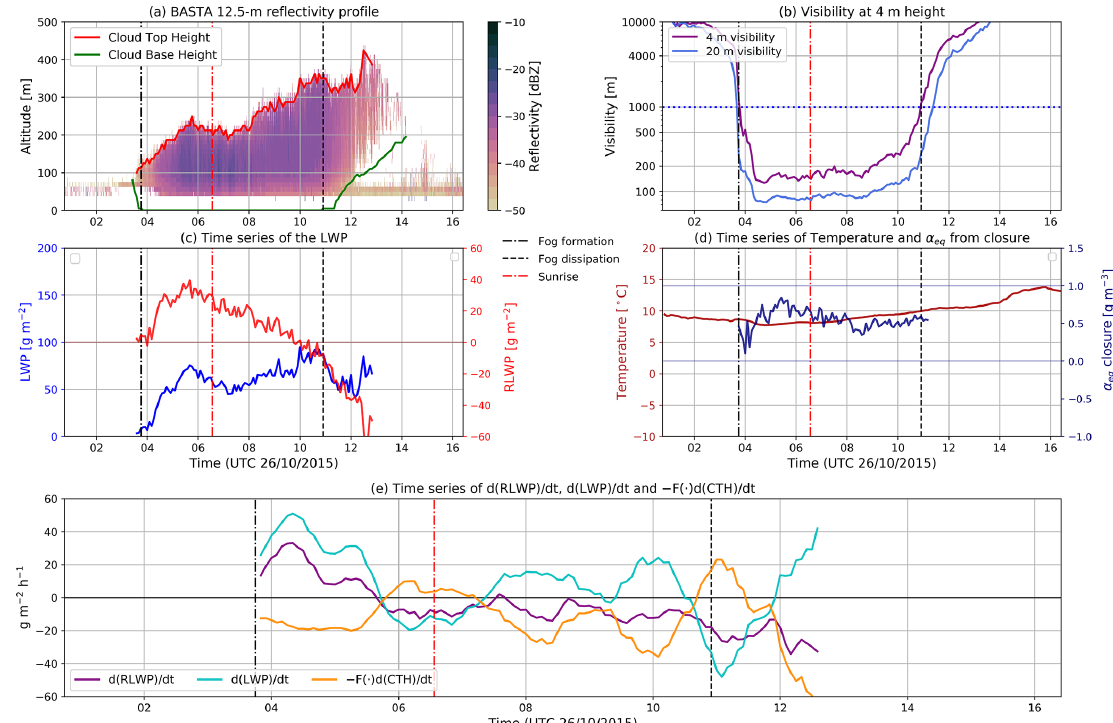
Figure 8. Case study 2. (a) Cloud base height (CBH), cloud top height (CTH), and the cloud radar 12.5m resolution reflectivity profile for the first 1000m of height. (b) Horizontal visibilities at 4 and 20m. (c) Fog–stratus layer measured LWP and computed RLWP. (d) Temperature and closure adiabaticity (calculated only when visibility is less than 2000m). (e) Change rate of RLWP, with the individual contributions from LWP and CTH variations. In each panel, the time of fog formation and fog dissipation are clearly marked as is the time of sunrise.